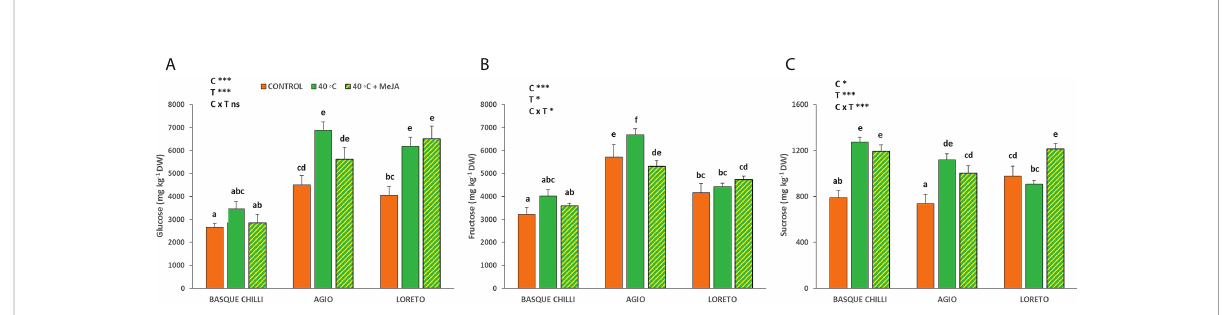
FIGURE 3 Effects of heat shock and MeJA on leaf carbohydrate concentration [ (A) glucose, (B) fructose and (C) sucrose] of the three pepper cultivars. Values are means ± SE. Different letters indicate signi fi cant differences between treatments according to Duncan ’ s test at the 95% con fi dence level. The * refers to signi fi cant differences at the level of p ≤ 0.05; ***p ≤ 0.001; n.s., not signi fi cant. C is cultivar; T is